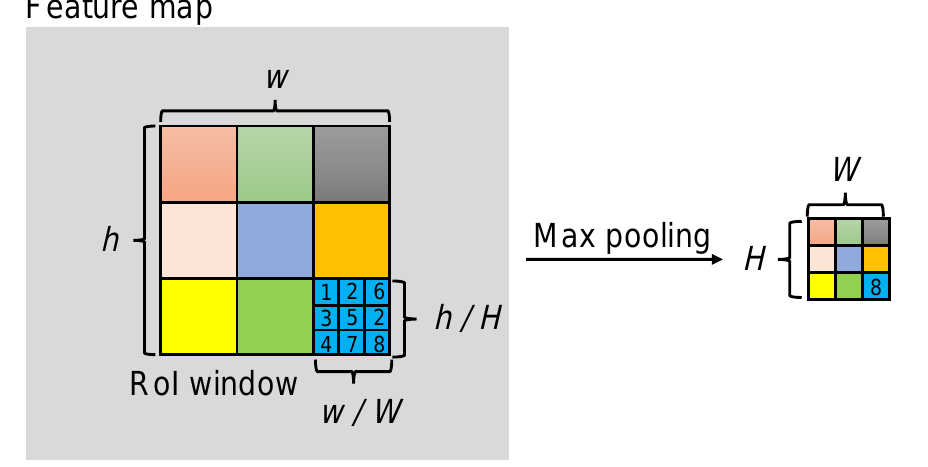
Figure 6. Illustration of the RoI pooling